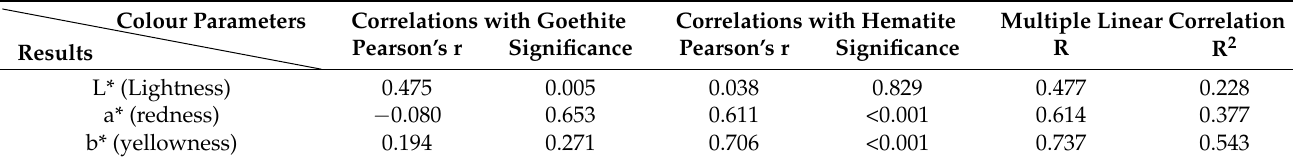
Table 3. Multiple linear regression and correlation results between colour parameters and approxi- mate content of goethite and hematite in samples calculated from K-M 2nd derivative